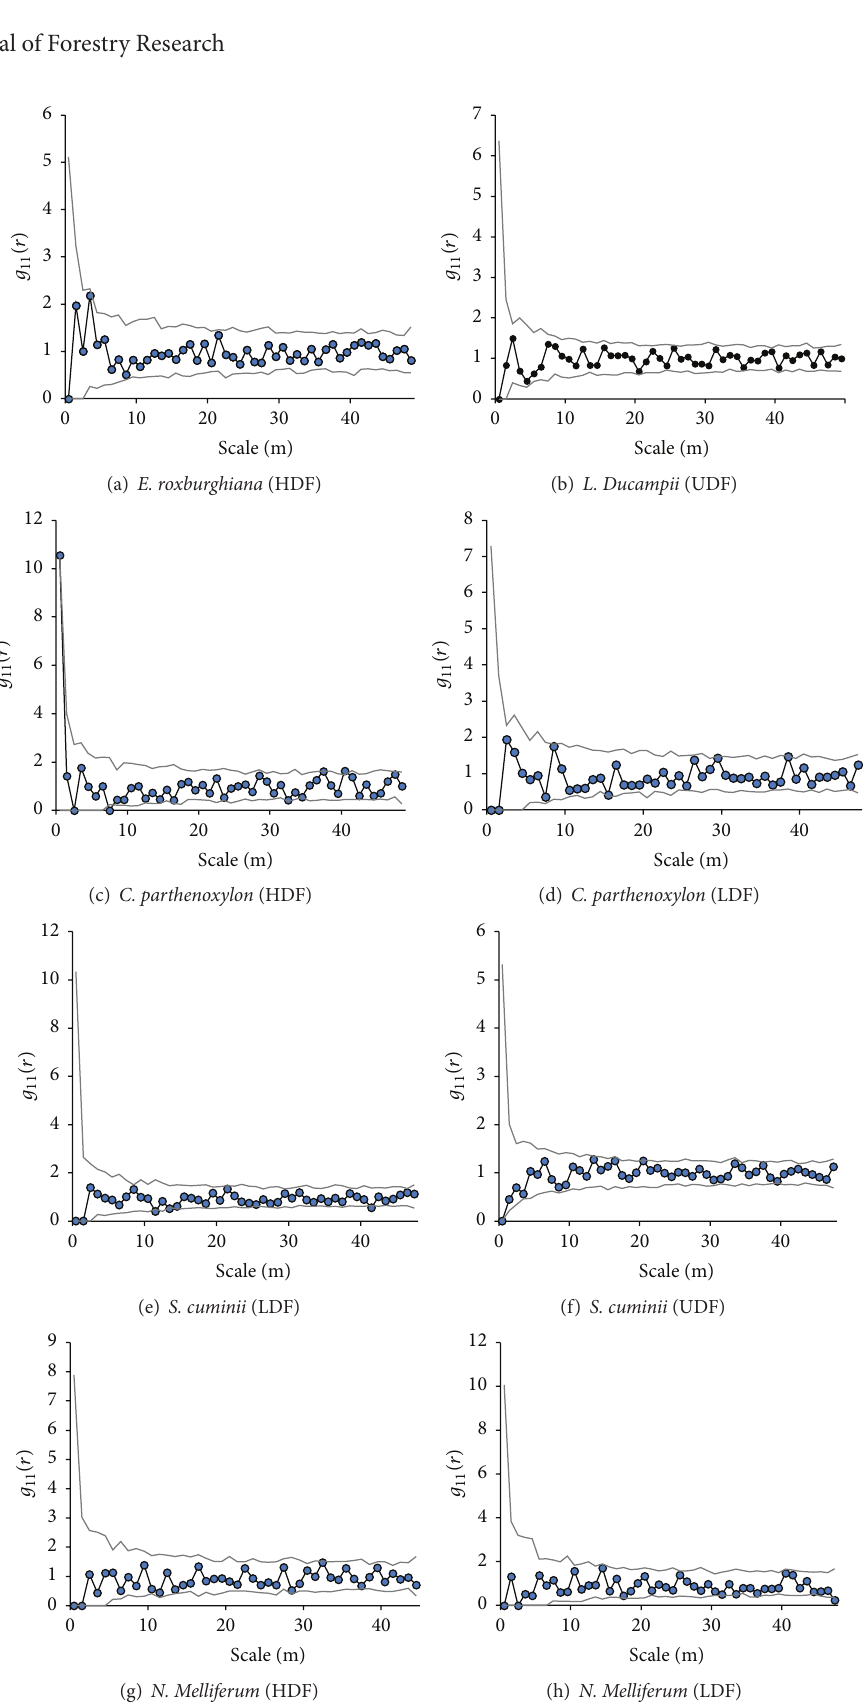
Figure 6: Spatial patterns of the five most abundant tree species shown by the pair-correlation function 𝑔(𝑟) with the null model of CSR. Black lines are observed patterns and grey lines are approximate 95% confidence